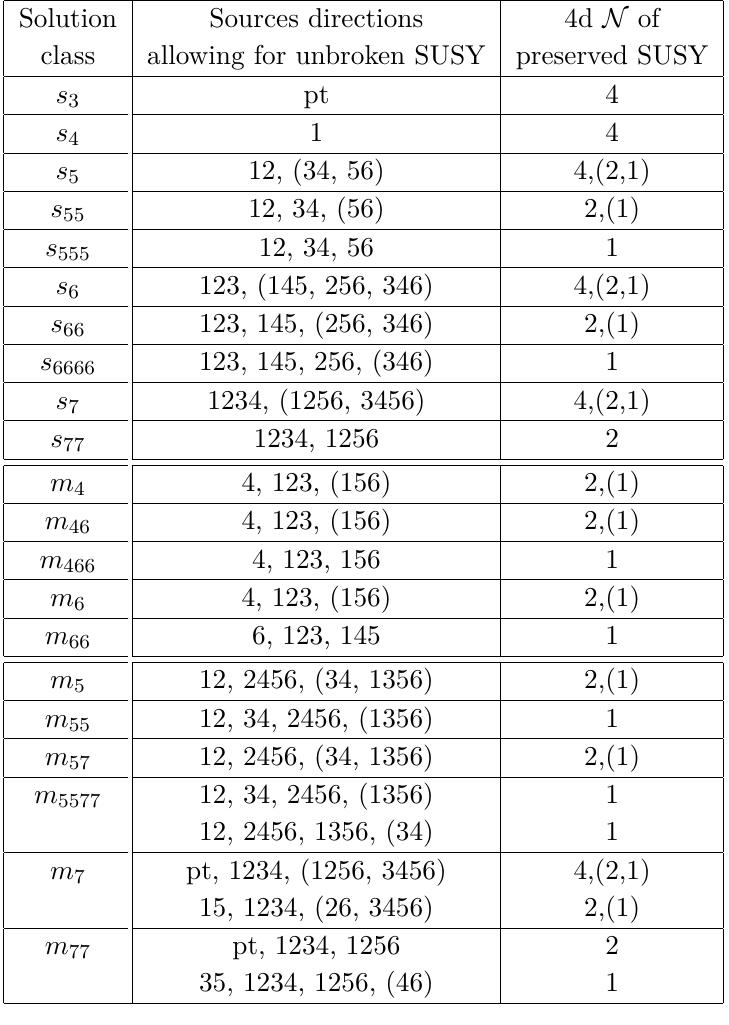
Table 5 . Internal directions of the source sets that allow for unbroken supersymmetry, for each solution class previously identified. The corresponding number N of preserved supersymmetries in 4d is given. The sets in parentheses are optional in the class, to which the amount N in parentheses corresponds. Some classes allow for different supersymmetry-preserving configurations, then specified on distinct